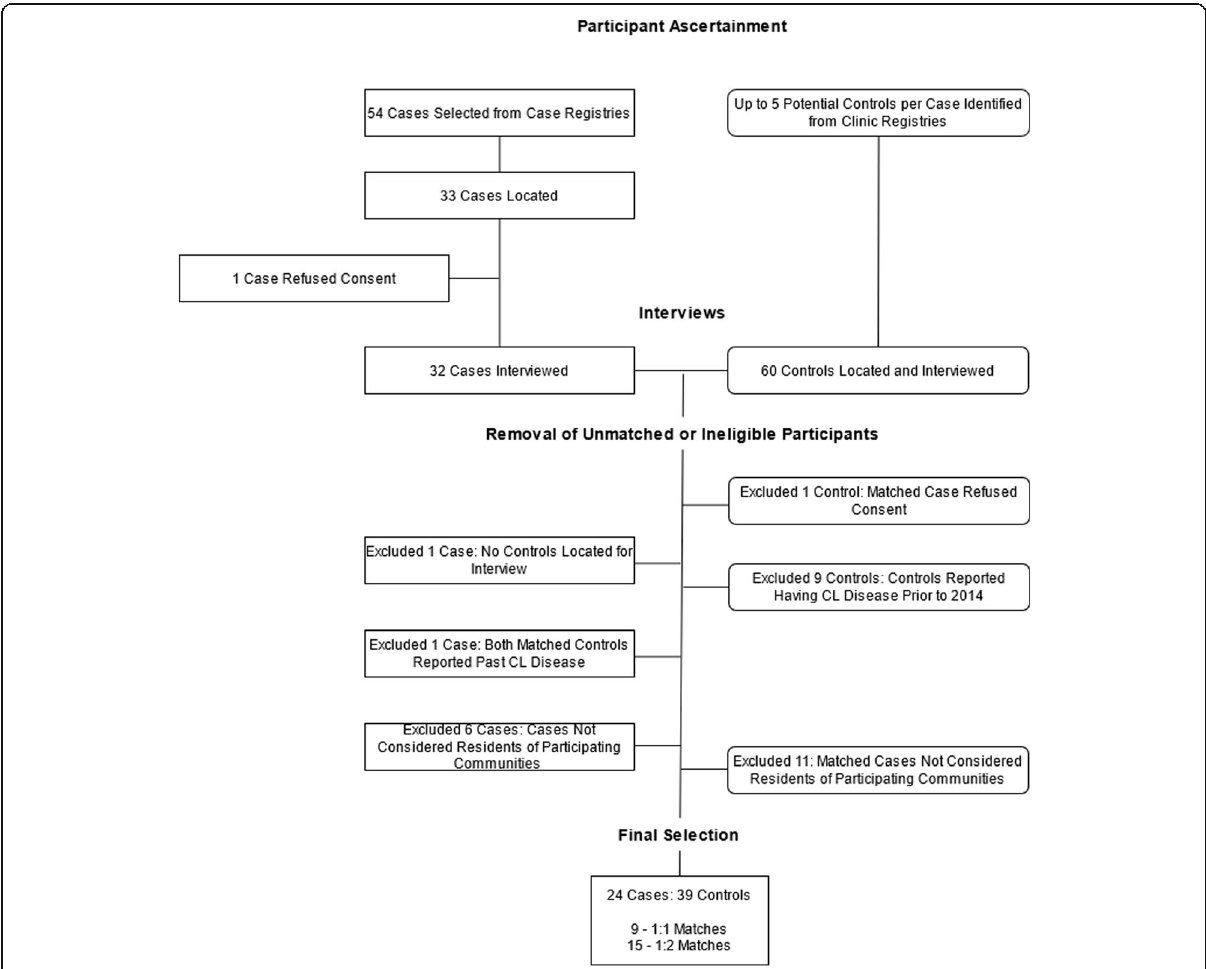
Fig. 3 Study enrollment flow chart. Cases and controls identified in the registries were interviewed in no particular order. In some instances, a control was interviewed before their matched case, which explains why controls with no cases may have been interviewed but later dropped from